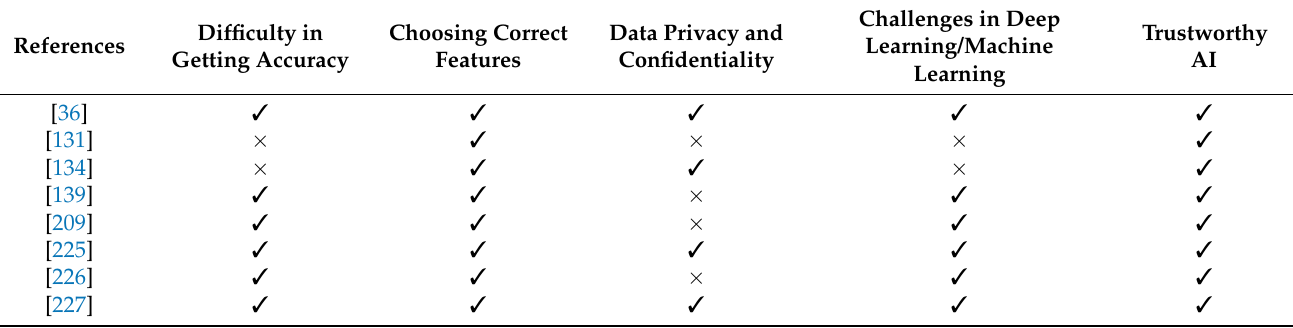
Table 5. Open Challenges for Oral Cancer